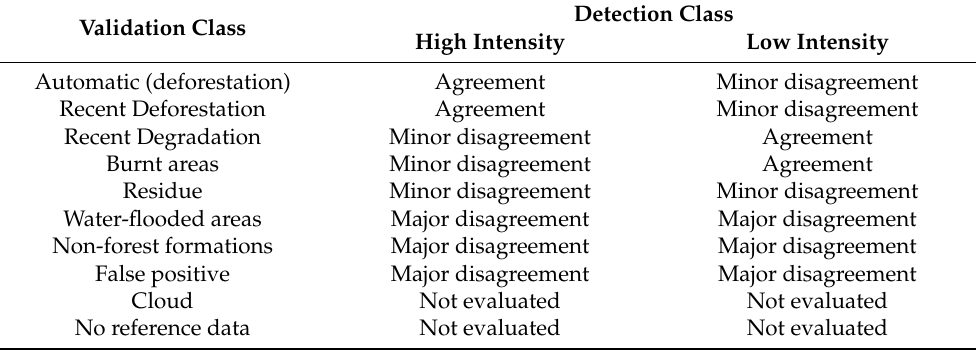
Table 1. Validation